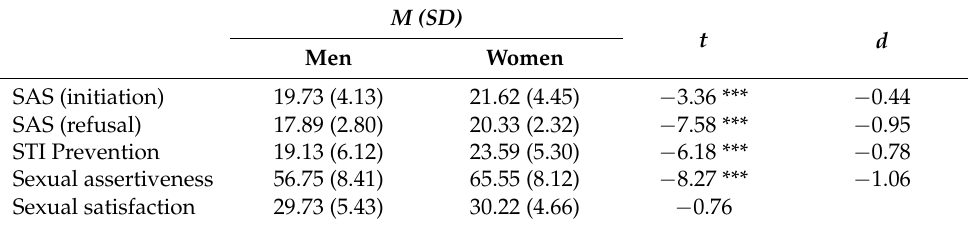
Table 2. Gender differences in the mean scores of sexual assertiveness and sexual satisfaction. M (SD)